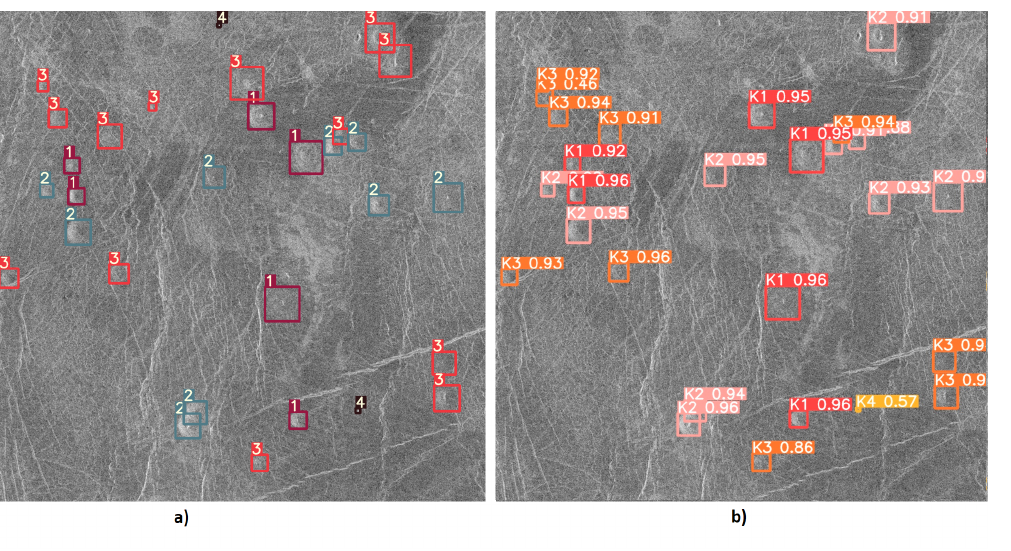
Figure 19. Input and output image used for testing model-3: ( a ) Input image with given objects for detection. ( b ) Output image with the detected